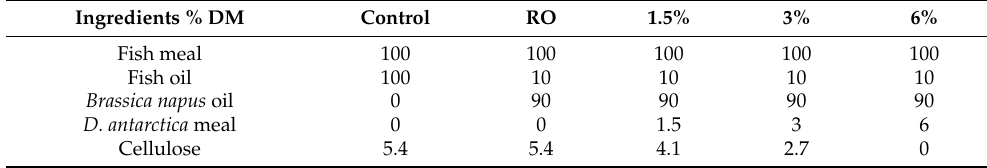
Table 1. Dietary ingredients for the experimental feeding of rainbow trout ( Oncorhynchus mykiss